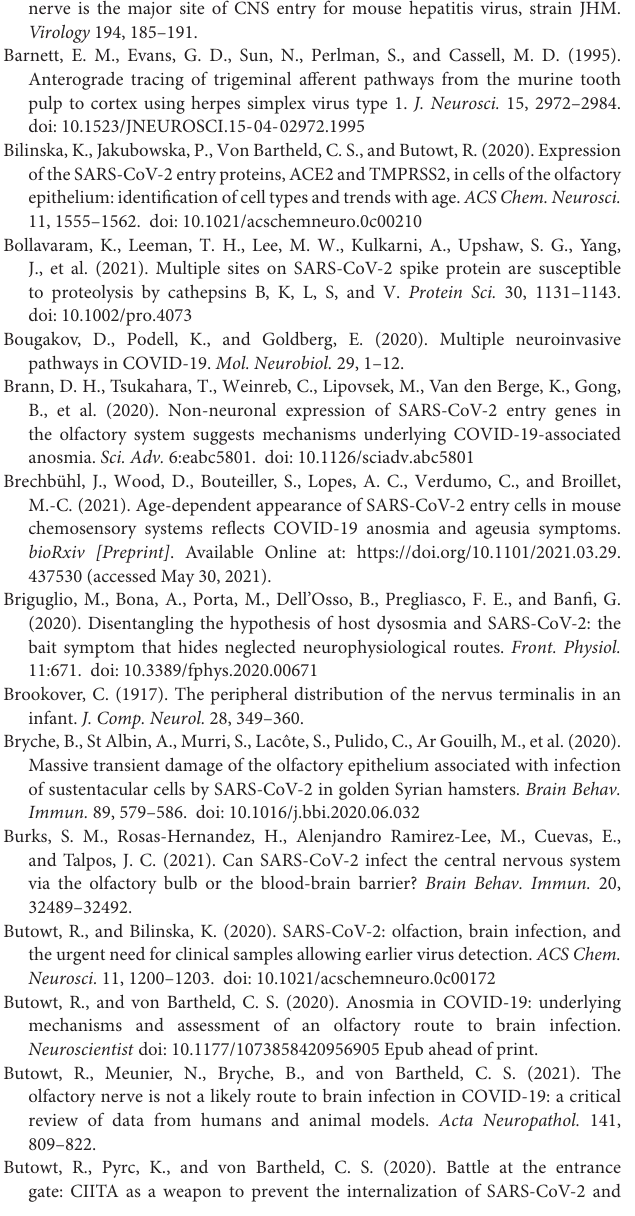
Supplementary Figure 1 | Examples of double immunofluorescent labeling of nervus terminalis neurons with the markers GnRH and olfactory marker protein (OMP) (A–D) , and GnRH and TMPRSS2 (E) . Label for GnRH (A) and OMP (B) in the medial region adjacent to the olfactory bulbs as indicated in Figure 1 . Nuclei are stained with Hoechst 33258 (C) and the merged image is shown in (D) .